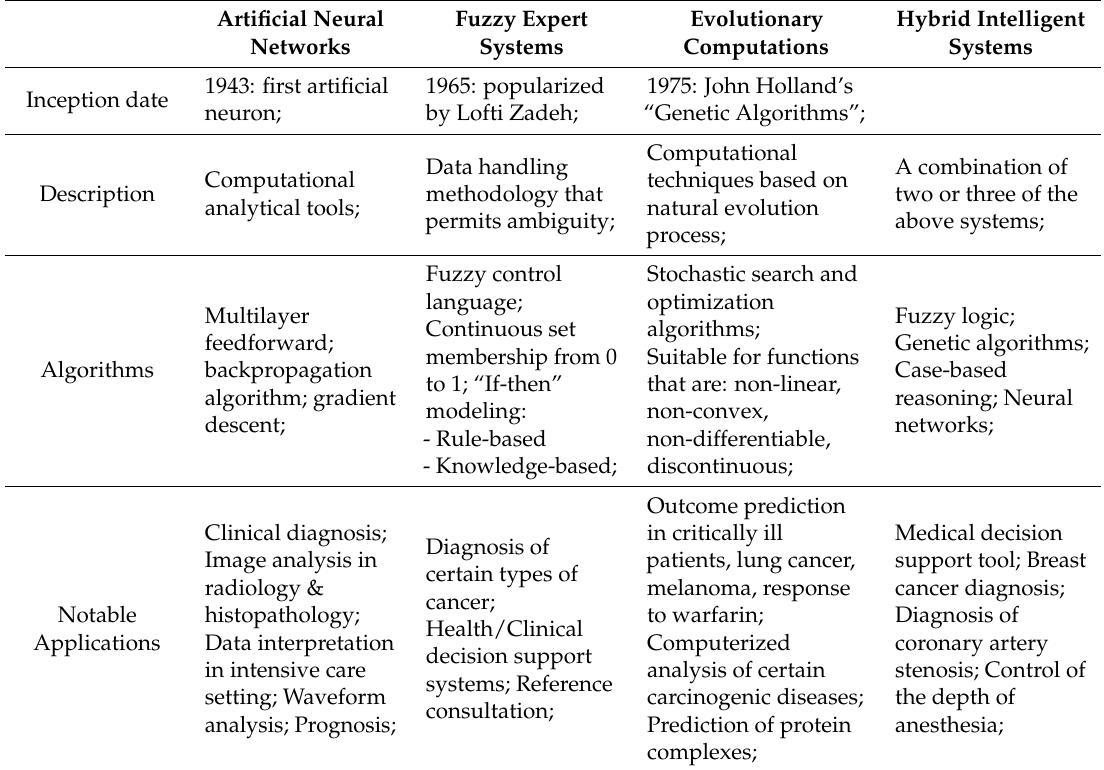
Table 1. Four major technological systems in AIM, as summarized by Ramesh, et al.